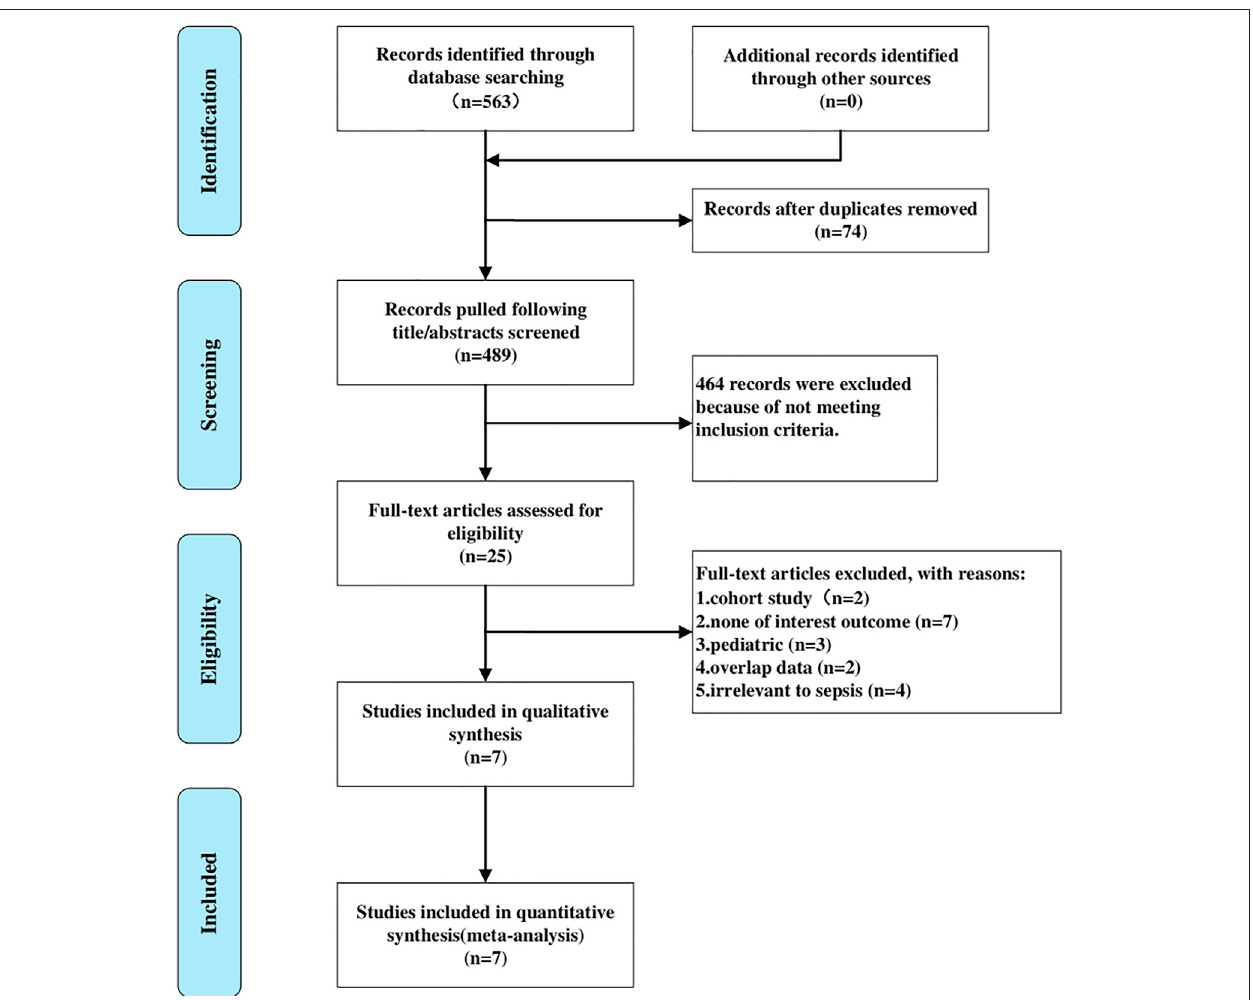
FIGURE 1 | Flow diagram of literature screening and selection